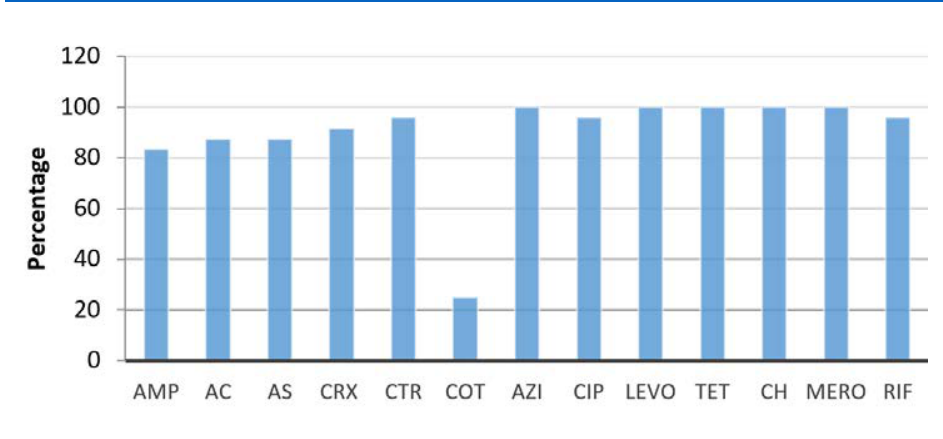
Fig. 1. H. influenzae Percentage Susceptibility *AMP- Ampicillin, AC- Amoxicillin-Clavulanic acid, AS- Ampicillin-Sulbactam, CRX- Cefuroxime, CTR- Ceftriaxone, COT- Co-trimoxazole, AZI- Azithromycin, CIP- Ciprofloxacin, LEVO- Levofloxacin, TET- Tetracycline, MERO- Meropenem, RIF-